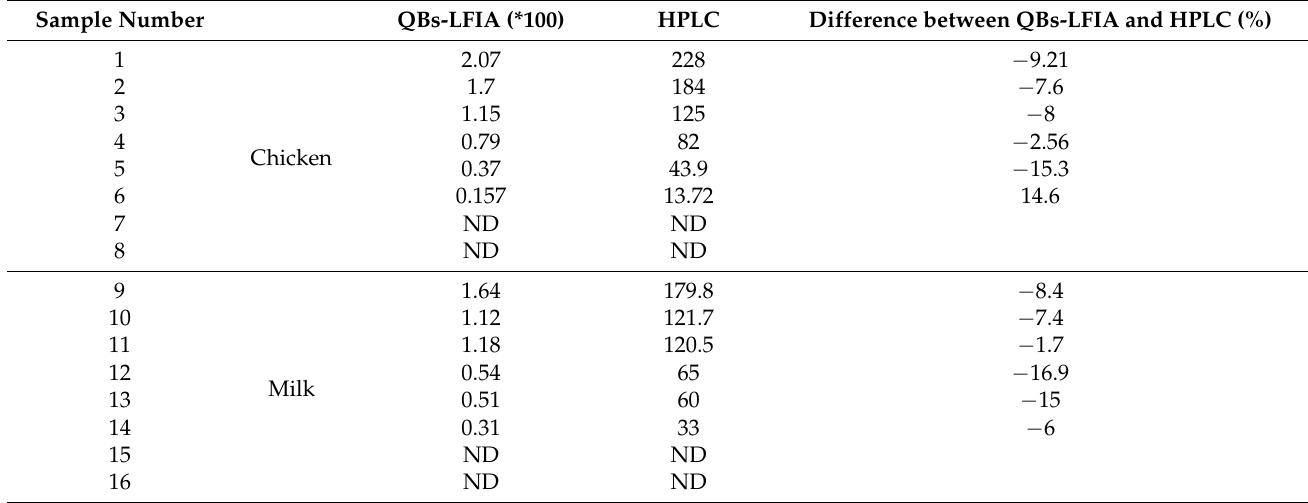
Table 3. Detection of SMZ in real samples using this method and